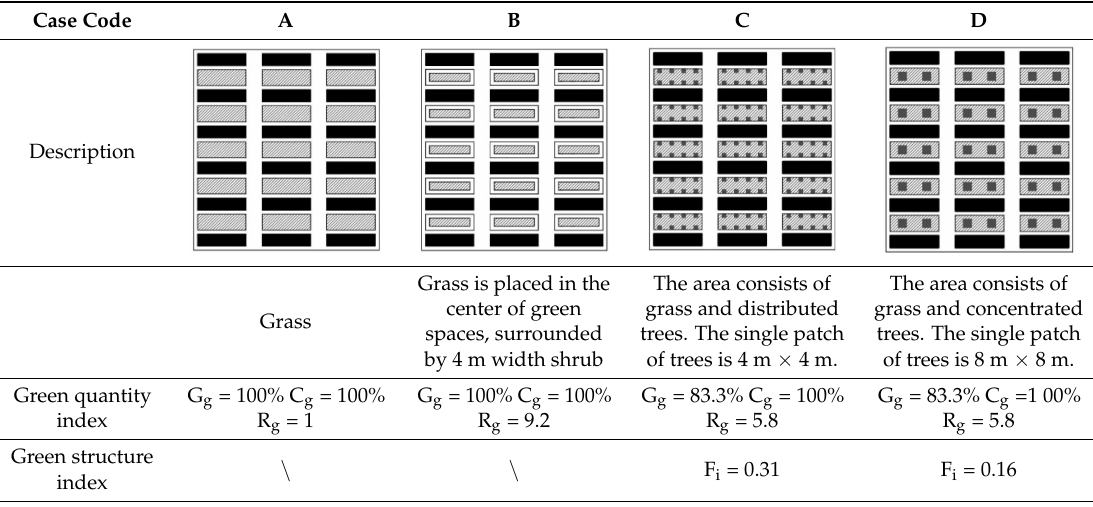
Figure 4. The idealized residential district area (highlighted in brown) of size 184 m × 200 m, with indication of the position of two receptors (P and Q) and pollutant line sources (dashed lines). Table 2. Investigated cases representing residential districts with different quantity and green structure